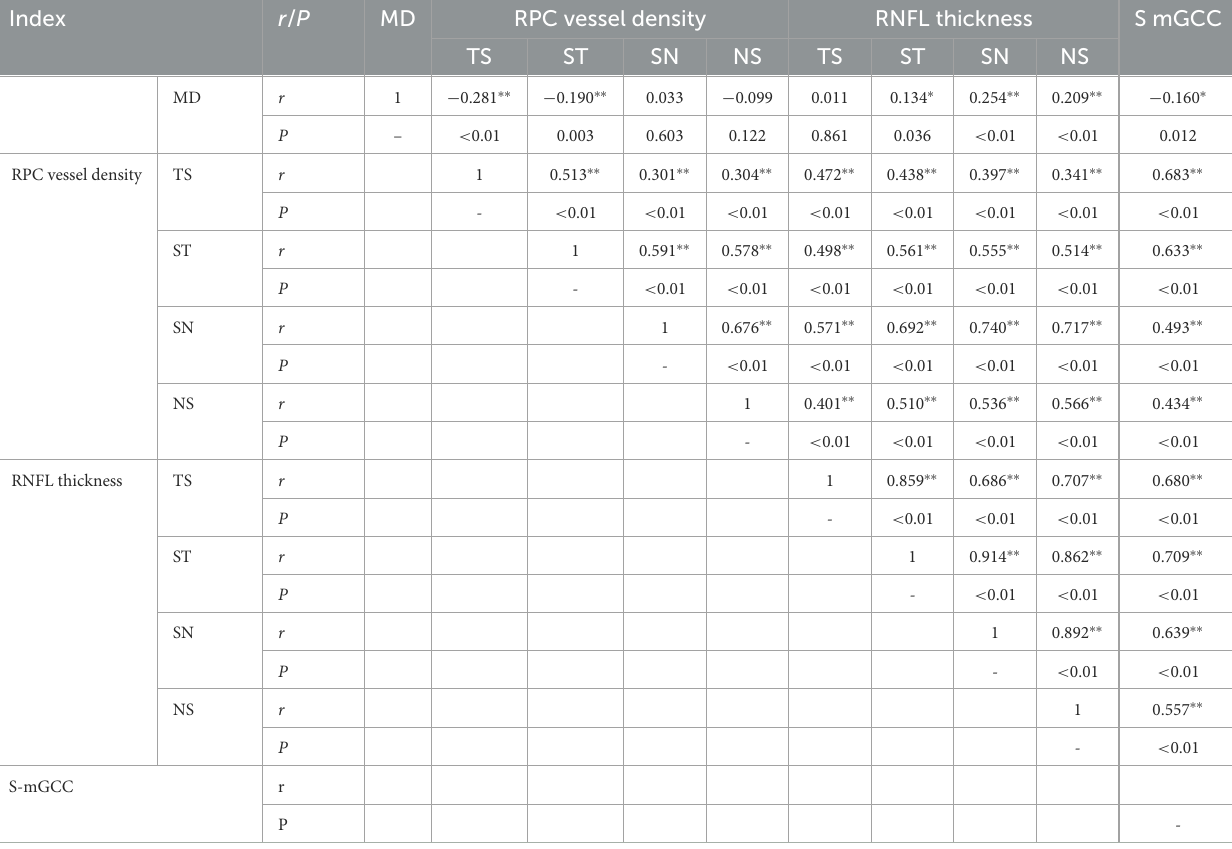
TABLE 5 Spearman correlation of MD and retinal